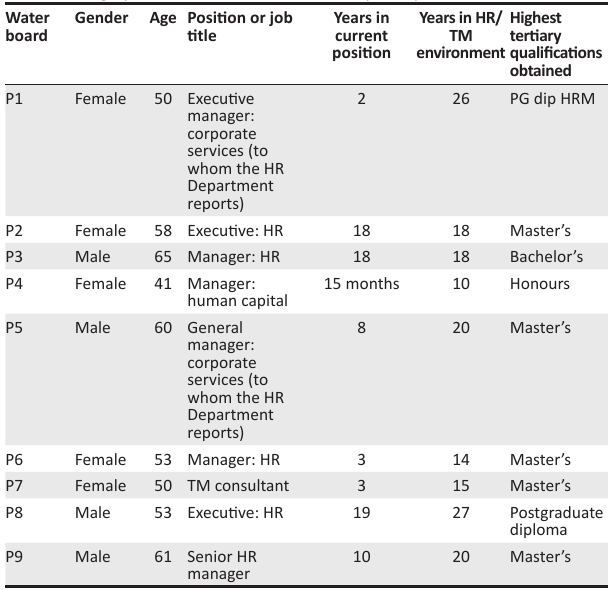
TABLE 2: Focused coding for employee value proposition. TABLE 1: Biographical overview of the research participants.